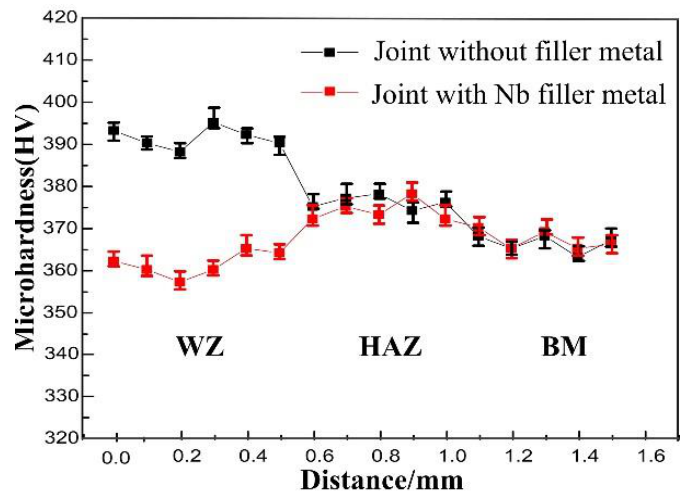
Figure 10. Microhardness profiles of laser-welded joints without and with Nb filler metal.